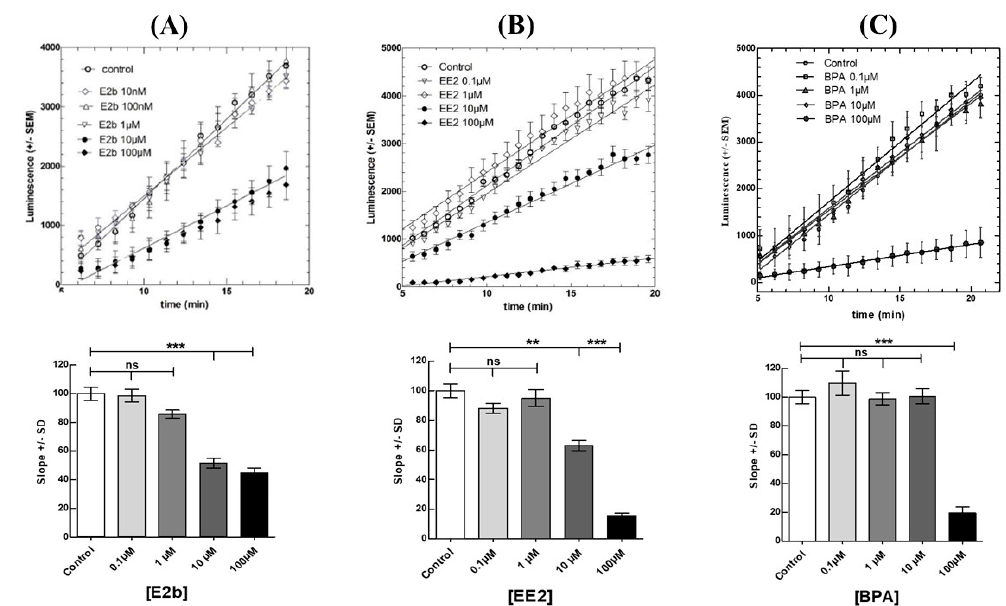
Figure 2. Effect of individual estrogenic molecules on the cAMP accumulation in mLTC-1 cells under stimulation by 0.7 nM hLH. Kinetics of oxyluciferin luminescence after 1h-preincubation with various concentrations of ( A ) 17 β -estradiol (E2 β ), ( B ) ethynylestradiol (EE2), and ( C ) bisphenol-A (BPA) are shown in the upper part. The corresponding dose-related effects are shown in the lower part. Each point represents the mean of luminescence in three wells in each condition. The figure presents one representative experiment out of three independent experiments. After checking for normal distribution, the data were analyzed by a paired Student’s t-test. * indicates a significant difference (** p < 0.01, *** p < 0.001) compared between control with each concentration of E2b or EE2 or BPA, ns = not statistically significant.